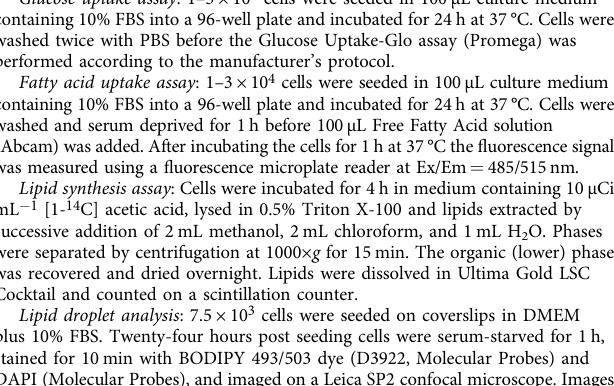
Fig. 6 Etomoxir treatment blocks AKR1B10-mediated metastasis. a 5 × 10 3 cells seeded into ultra-low adherence U-bottomed plates. Twenty-four hours post seeding 200 µ M etomoxir or vehicle was added and tumour spheroid viability assessed on day 6. n = 8 ± SD. Equivalent results were obtained in two independent experiments. b BALB/c Nude mice injected intravenously with 1 × 10 6 cells and treated with vehicle or etomoxir ( n = 5 – 7 per group). Lung tumour burden was assessed at the end of the experiment (day 55) by ex vivo IVIS imaging (dashed line indicates average radiance of aged-matched non- tumour bearing mice), lung weight and the mean % tumour area from three sections cut through the lungs 150 µ m apart ± SEM. Representative ex vivo IVIS images and lung sections are shown. Scale bar, 1 mm. ns, not signi fi cant; * P < 0.05; ** P < 0.01; *** P < 0.001; two-way ANOVA with Bonferroni